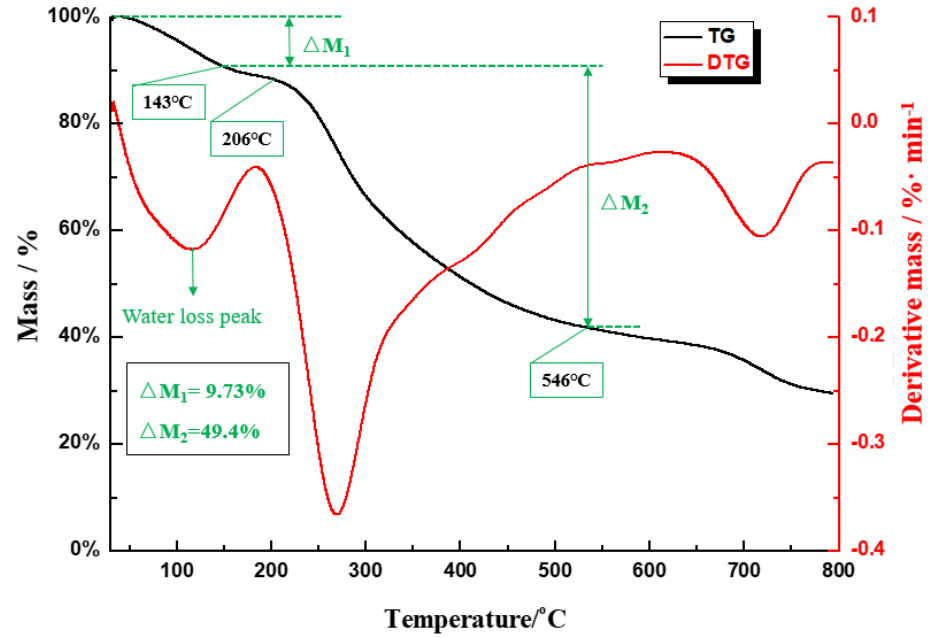
Figure 14. TG-DTG curve of dust suppressant sample.